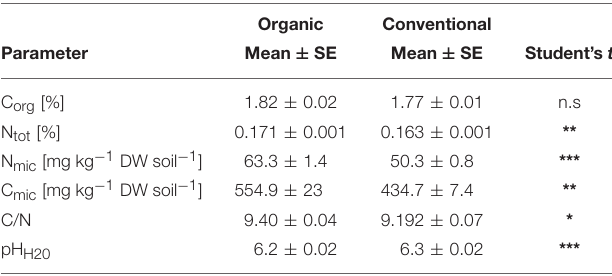
TABLE 1 | Soil biochemical properties of organic and conventional farming systems at the start of the experiments after lupine litter amendments. Organic